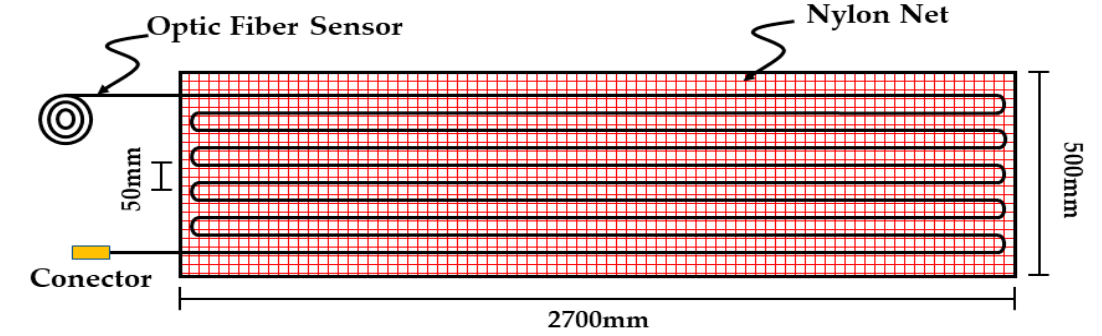
Figure 2. Geometry of the Brillouin optical time domain reflectometer (BOTDR) sensor placement.